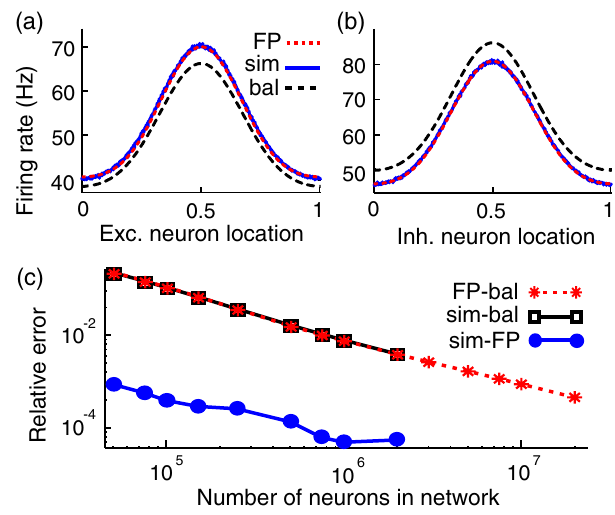
FIG. 3. Balanced network firing rates. (a) Population firing rates ν x Þ and ν x Þ calculated from full network simulations ( “ sim, ” solid e ð i ð blue line, N ¼ 2 × 10 6 ), the numerically computed fixed point in Eq. (12) ( “ FP, ” dotted red line, N ¼ 2 × 10 6 ), and the balanced solution from Eq. (9) ( “ bal, ” dashed black line). (b) Relative mean- square difference between the firing rates calculated using the three methods from (a) at various values of N